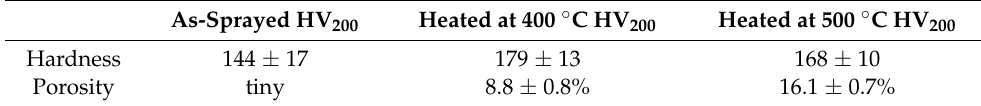
Table 4. Microhardness of the metal matrix in the coating and porosity in different